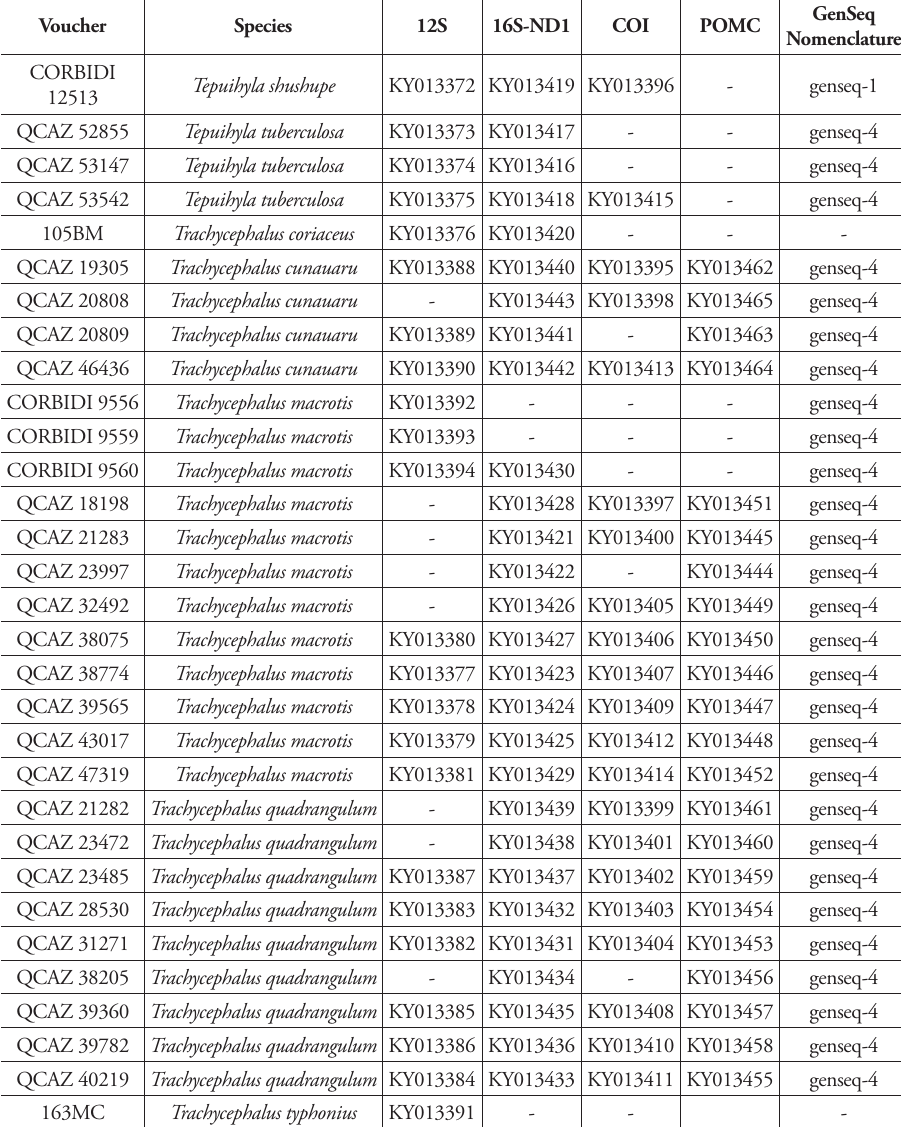
Table 1. New sequences generated for the phylogenetic analysis.